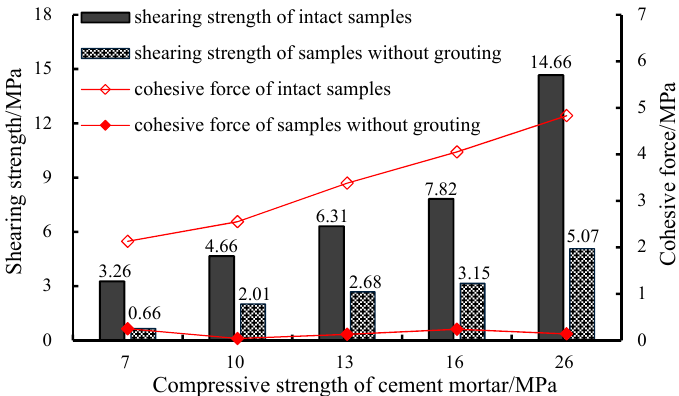
Figure 6. Results of the shearing experiment in the controlled group.